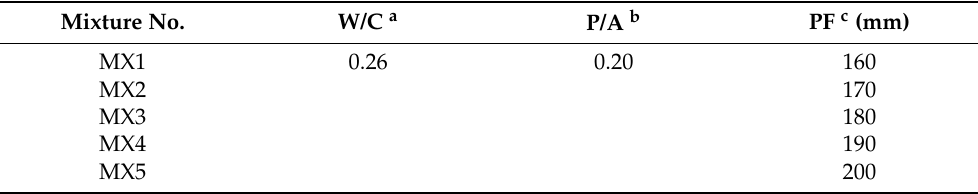
Table 3. Mix proportions of porous